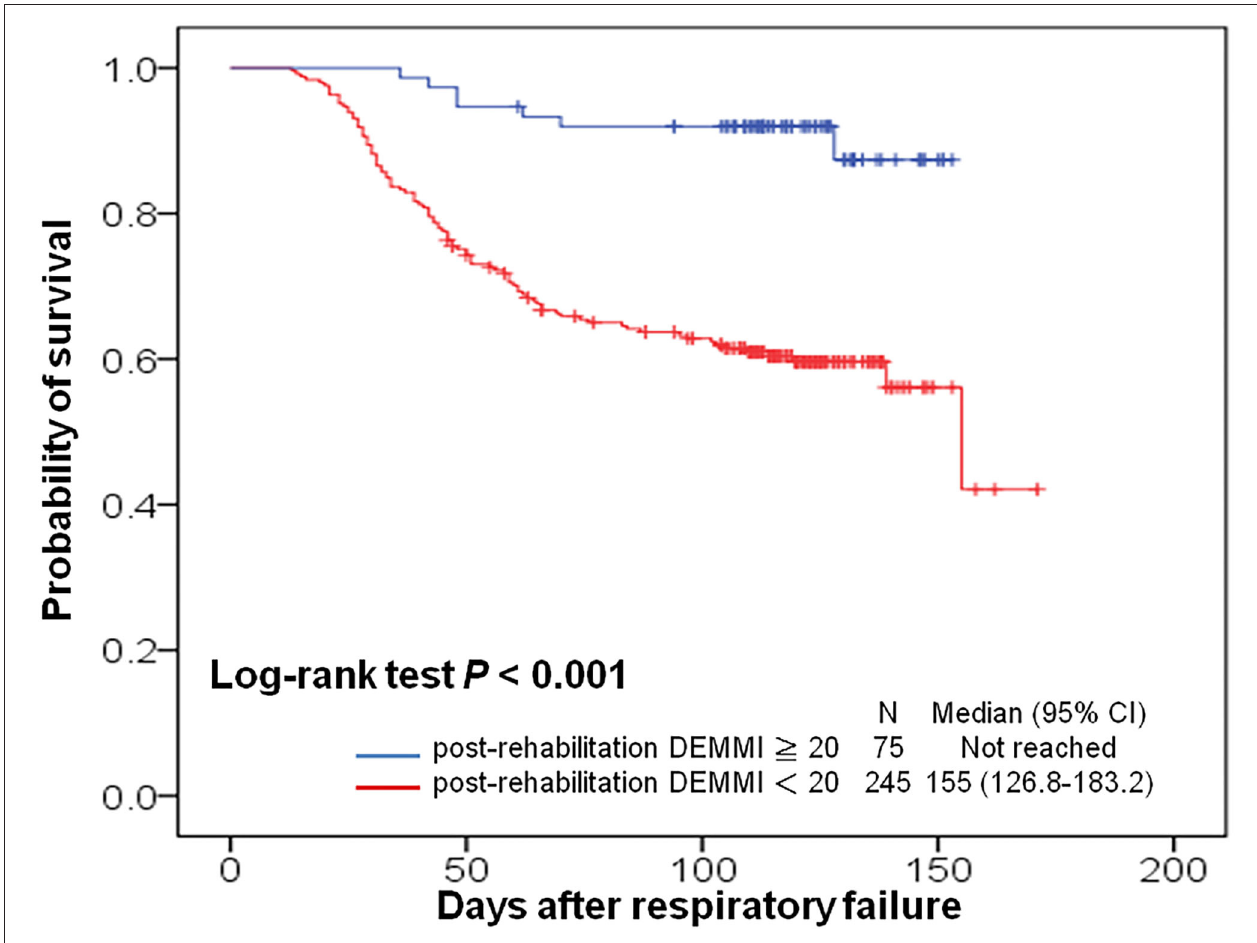
FIGURE 4 | Kaplan-Meier curves for overall survival in patients with prolonged mechanical ventilation, with stratification by post-rehabilitation DEMMI. CI, confidence interval; DEMMI, the de Morton Mobility